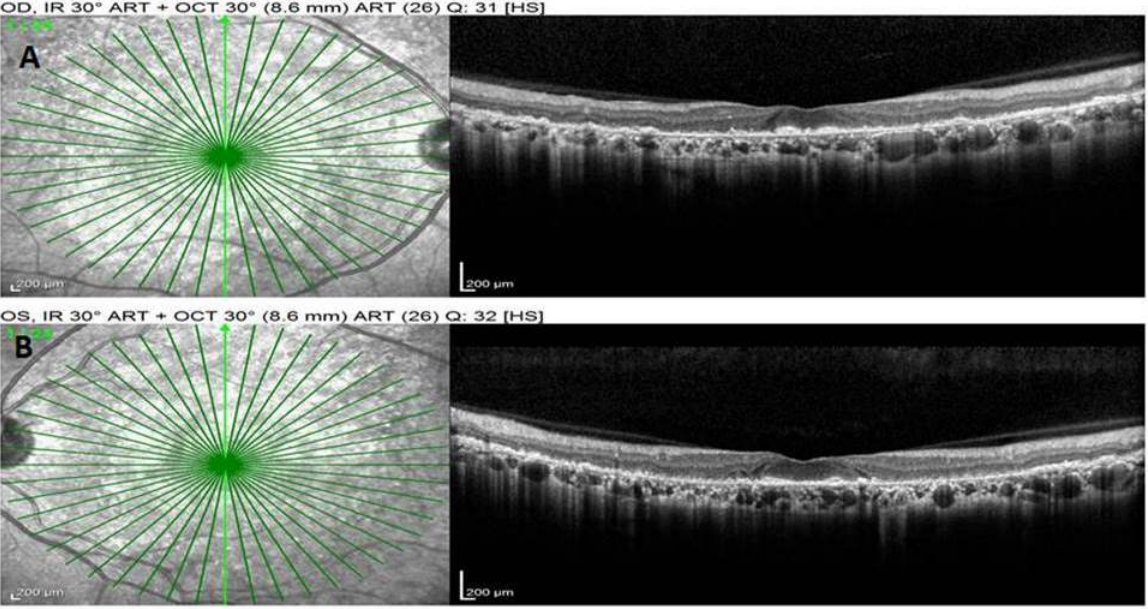
Figure 4: Spectral domain optical coherence tomography (SD-OCT) showed complete loss of the ellipsoid layer and external limiting membrane, although inner retinal layers were